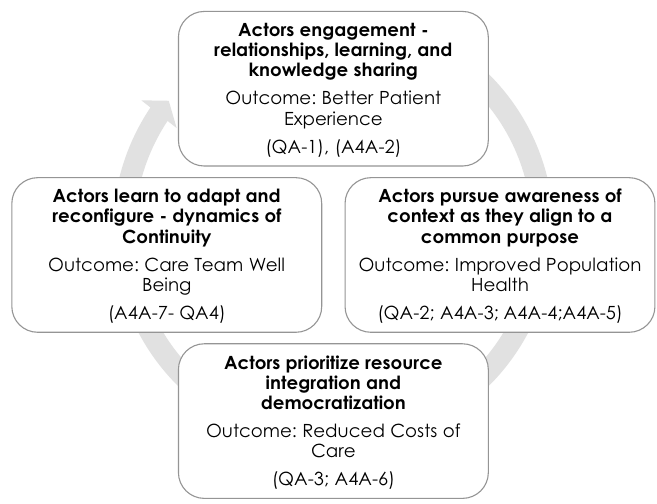
Fig.3. Quadruple Aim through the lens of A4A for actor engagement -